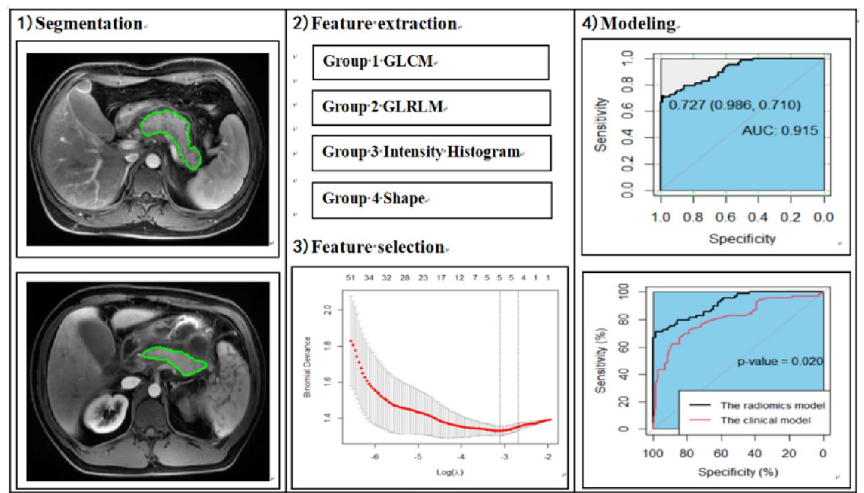
Figure 2. Flowchart of radiomics analysis. GLCM, gray-level co-occurrence matrix; GLRLM, gray-level run- length